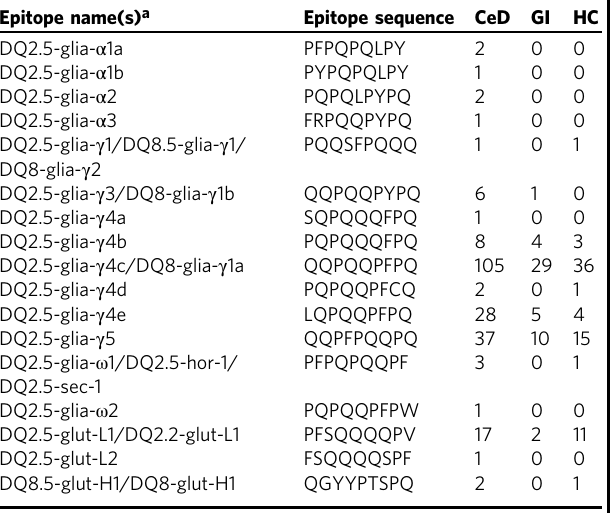
Fig. 11. Full details on LC – MS/MS identi fi cation of peptide sequences are provided in Supplementary Dataset 7. Source data are provided as a Source Data fi le.